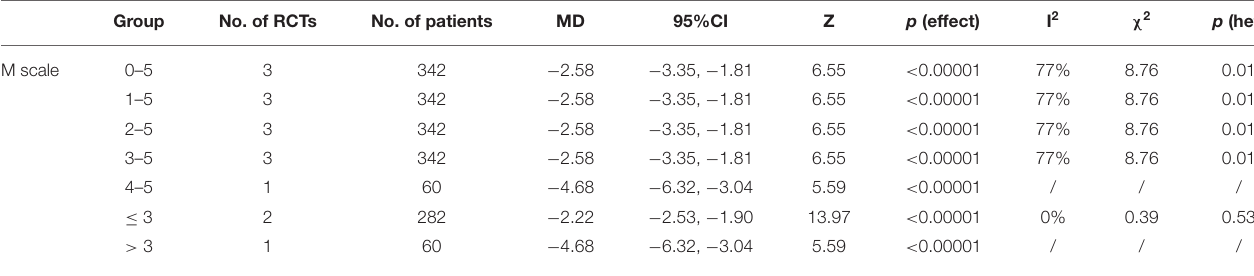
TABLE 5 | Sensitivity analysis based on the frequency of angina attacks.